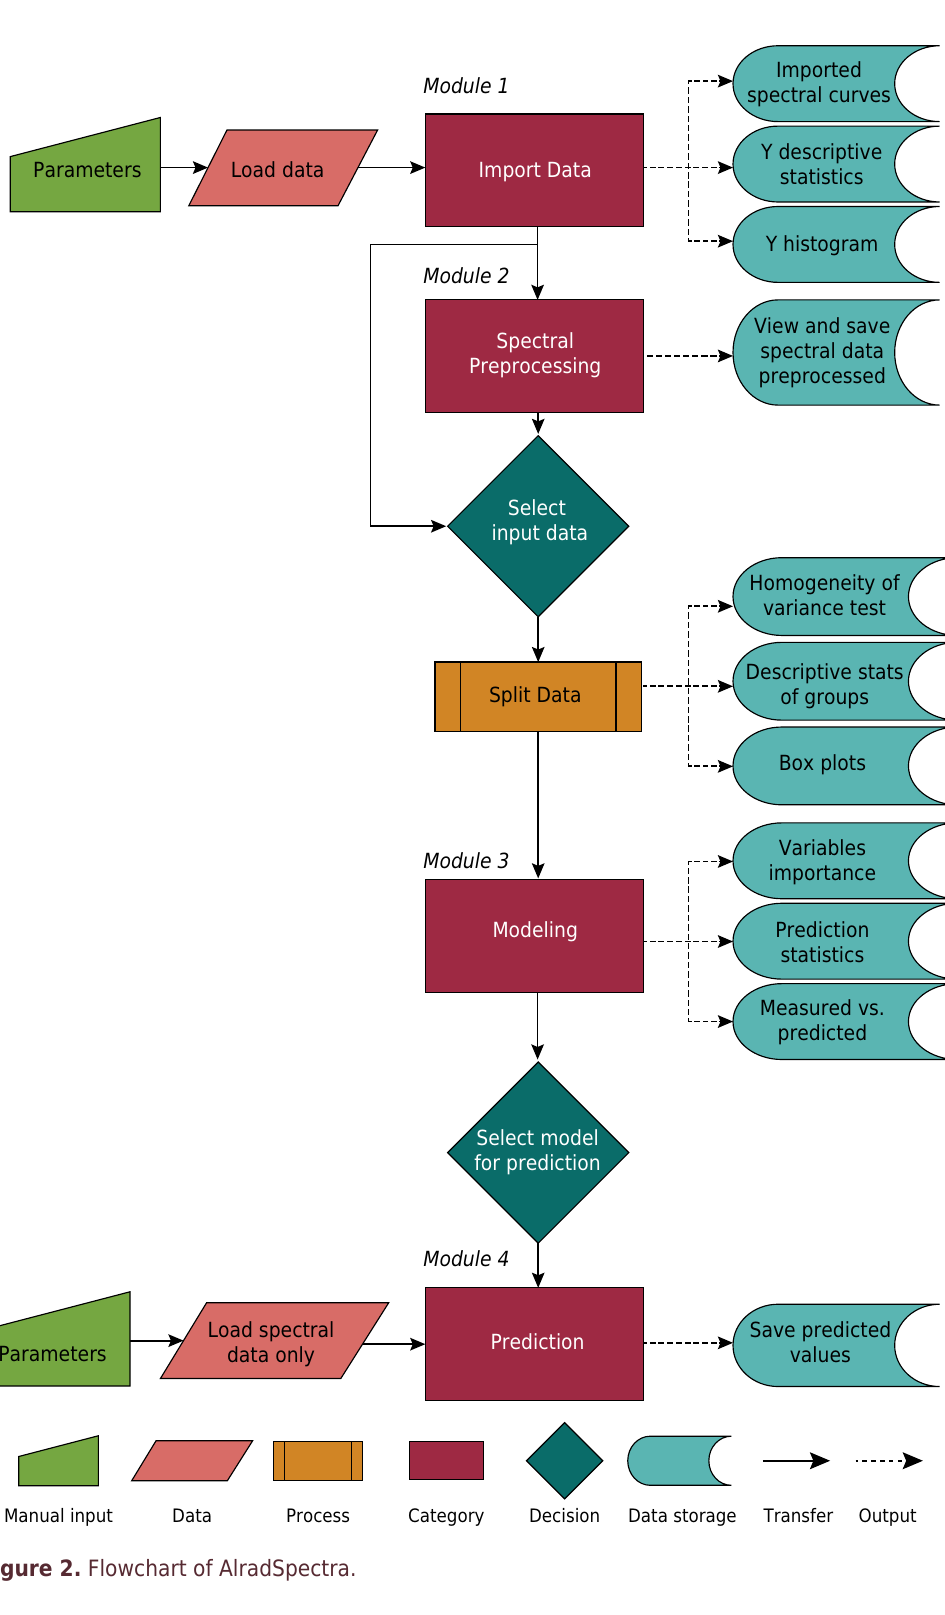
Figure 2. Flowchart of